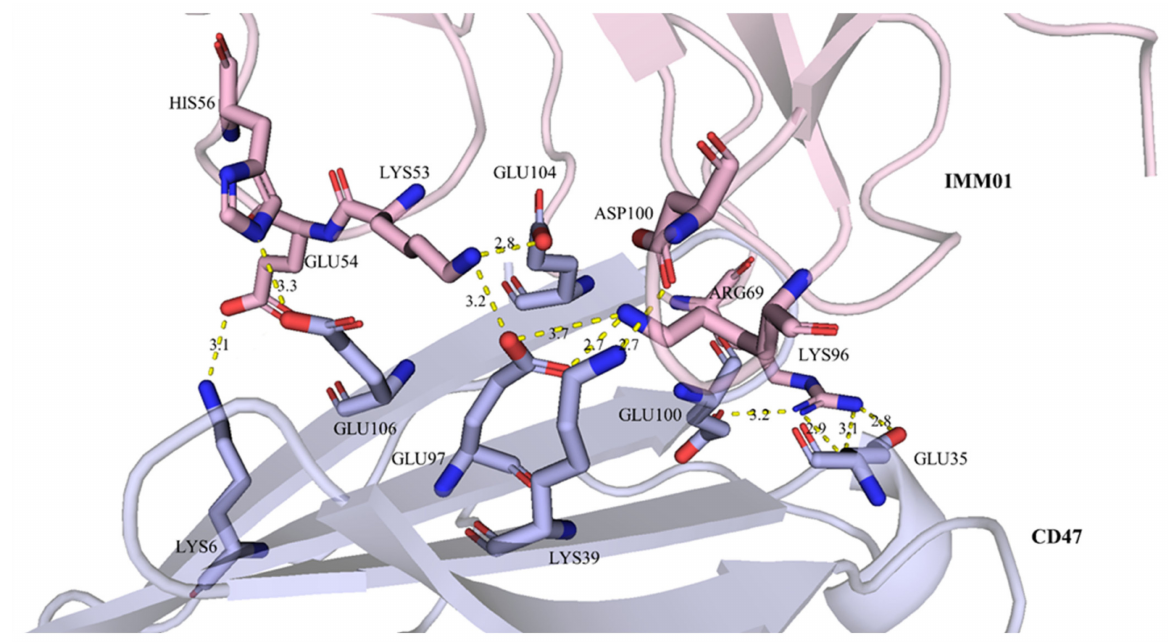
Figure 6. Salt bridge bond interactions between chain A (IMM01) and chain C (CD47). Chain A and chain C are shown in pink and light blue, respectively. The residues forming salt bridge bonds are shown as sticks, salt bridge bonds are highlighted as yellow dashed